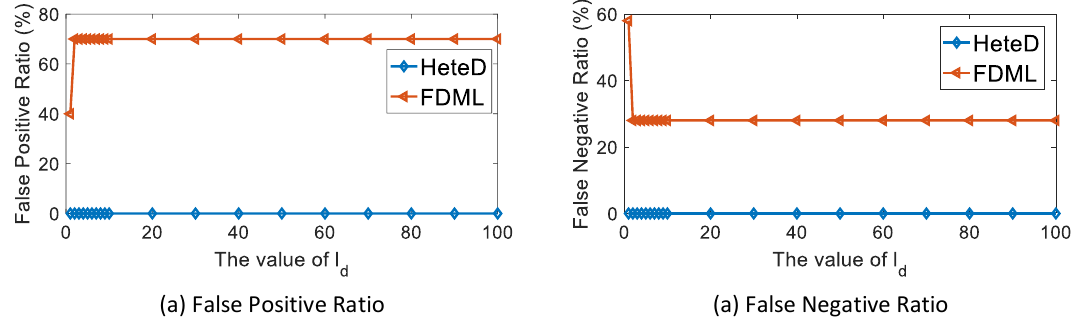
Figure 10. Detection performance of detectors on the tank